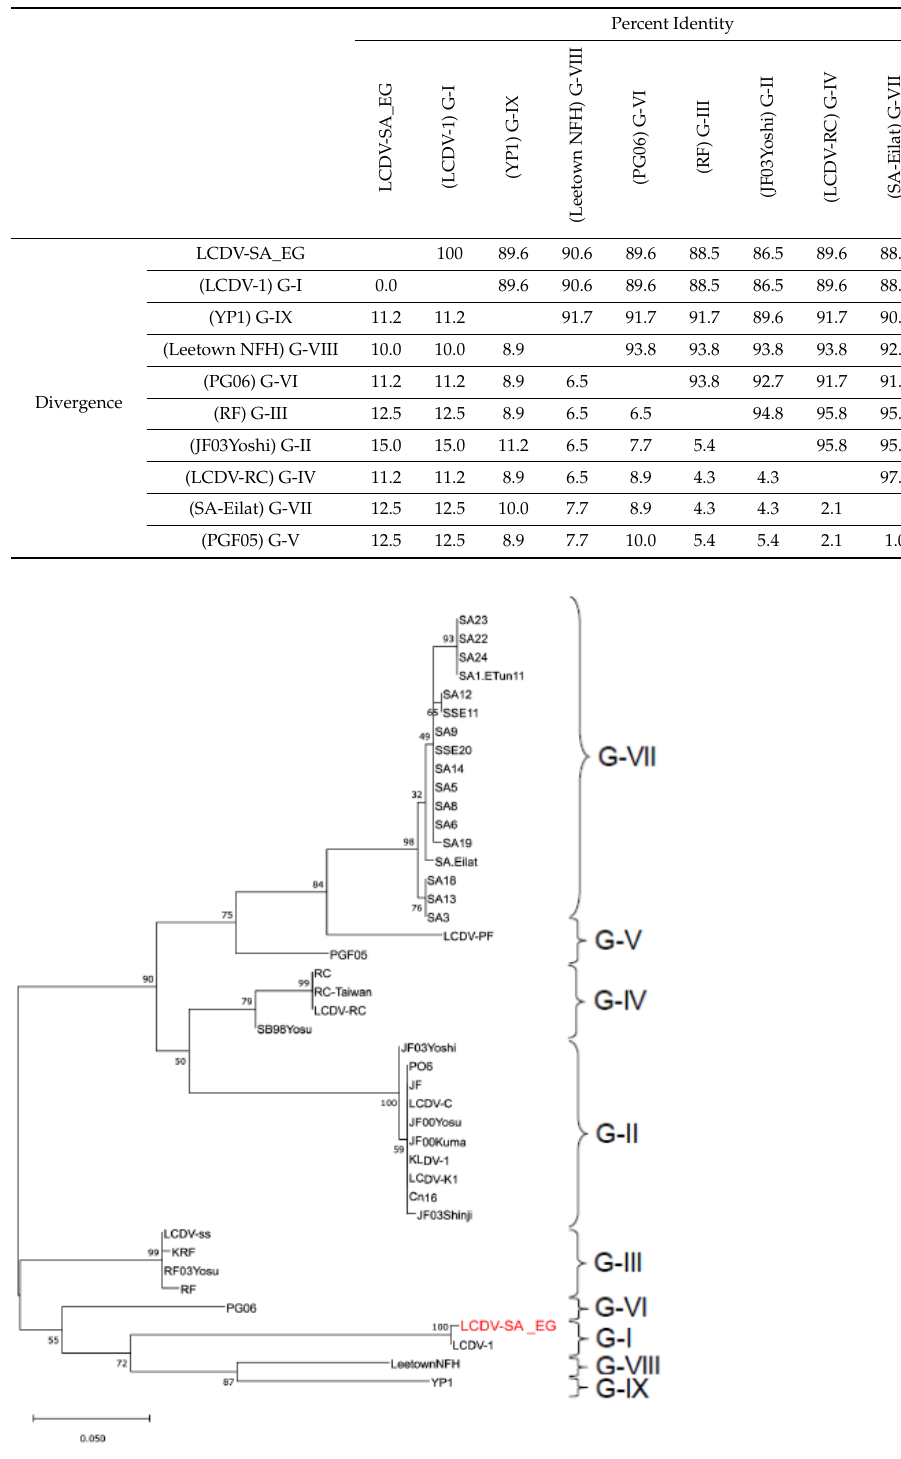
Figure 6. Dendrogram depicting the relationship between LCDV-SA_EG MCP sequence and representative sequences from other LCDV genotypes. The Maximum Likelihood method and Tamura − Nei model were used for phylogenetic analysis. The study sequence is in bold red. The percentage of trees in which the associated taxa are clustered together is shown next to the branches. The scale represents the number of substitutions per site.